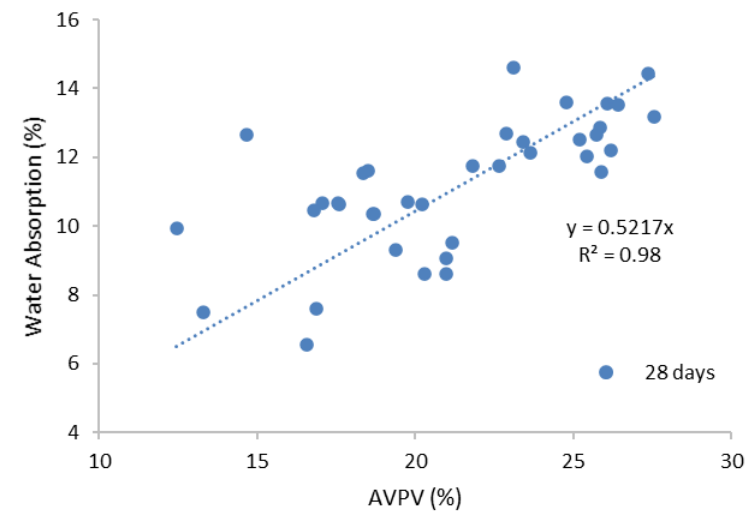
Figure 8. AVPV and water absorption relationship.